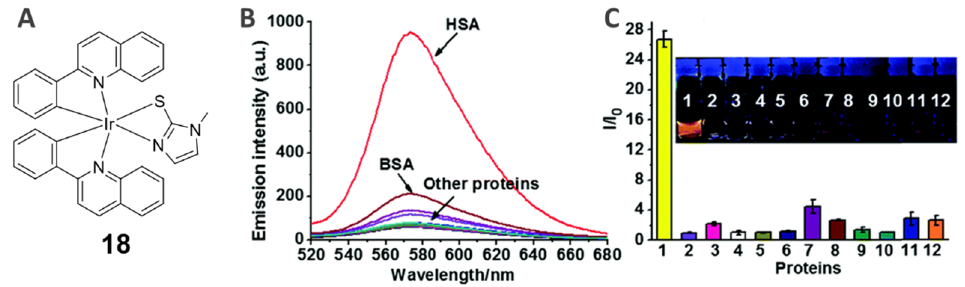
Figure 13. ( A ) Chemical structure for complex 18 . ( B ) The phosphorescence spectra of complex 18 (5 μM) in the presence of various proteins (50 μg mL −1 ). ( C ) The turn-on phosphorescence ratio of complex 18 with different proteins. Reproduced with permission from ref. [89]. Copyright 2018 MDPI AG.